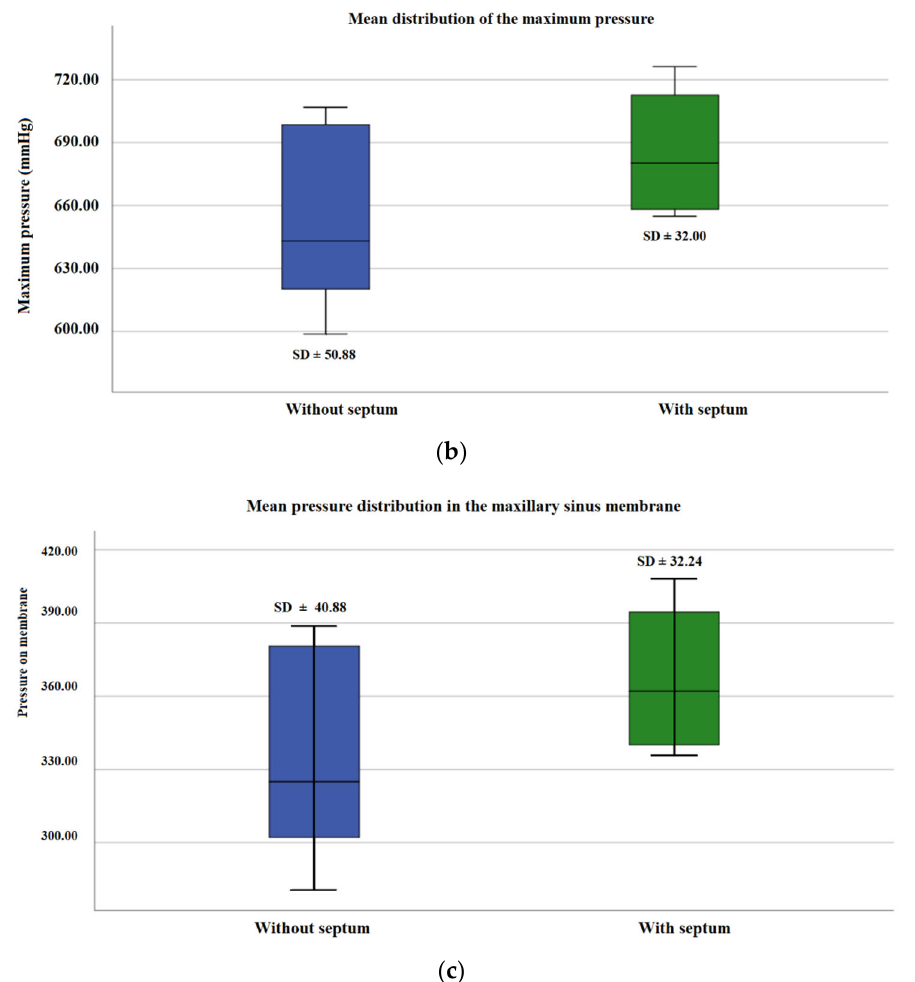
Figure 4. ( a ) General distribution of maximum pressure in the maxillary sinus. ( b ) Distribution of mean maximum pressure in the maxillary sinus with and without a septum. ( c ) Mean pressure distribution in the maxillary sinus membrane with and without a septum.